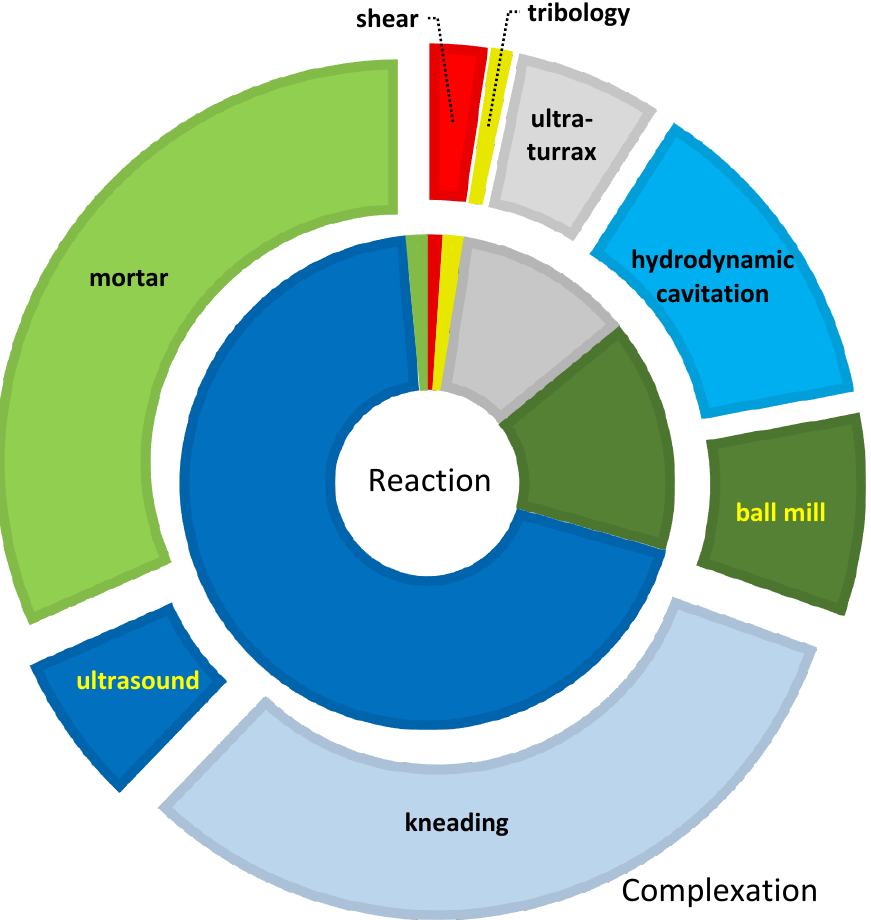
Figure 3. Participation of various mechanochemical methods in chemical transformations (inner slices) and complex preparations (outer arcs) in technical papers till 28 July 2021. Due to the overlaps of some topics, such as grinding and kneading, hydrodynamic cavitation/ultra-turrax, and ultrasonic mixing, the percentages carry little